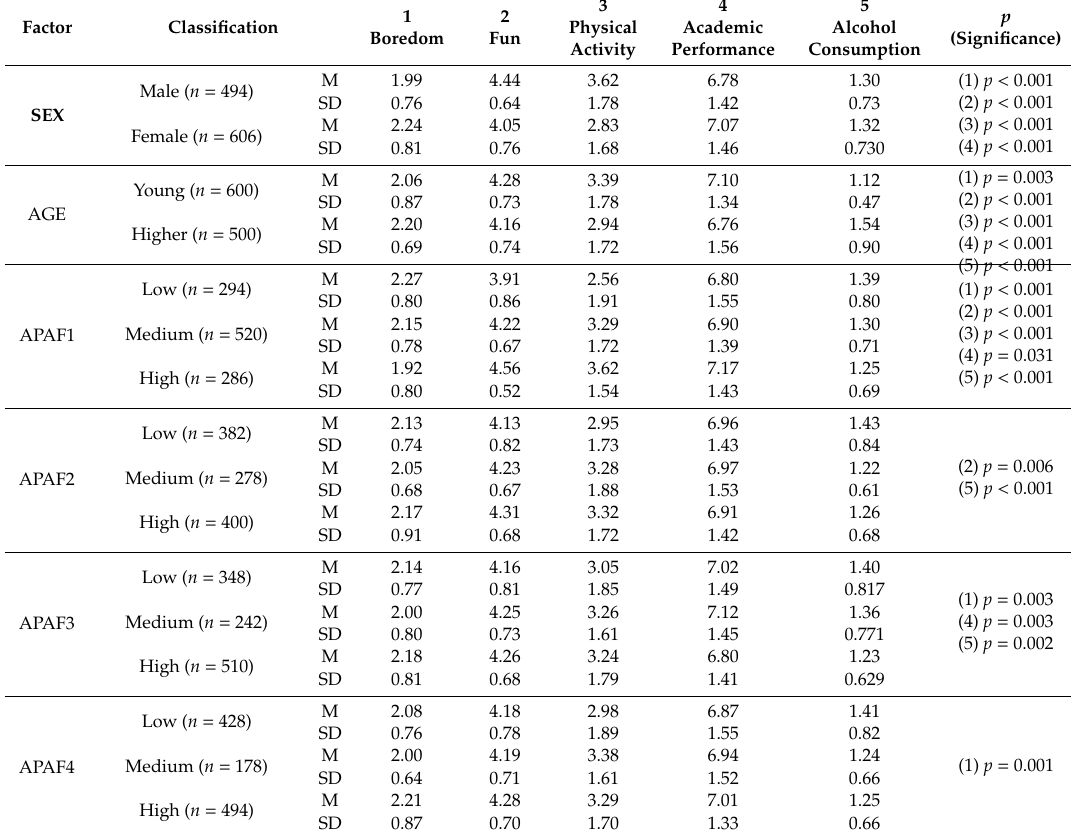
Table 1. Descriptive analysis of the dependent variables of boredom, fun, physical activity (PA) practice, academic performance and alcohol consumption. Analysis according to the factors of gender, age and Parental Support for Physical Activity Questionnaire